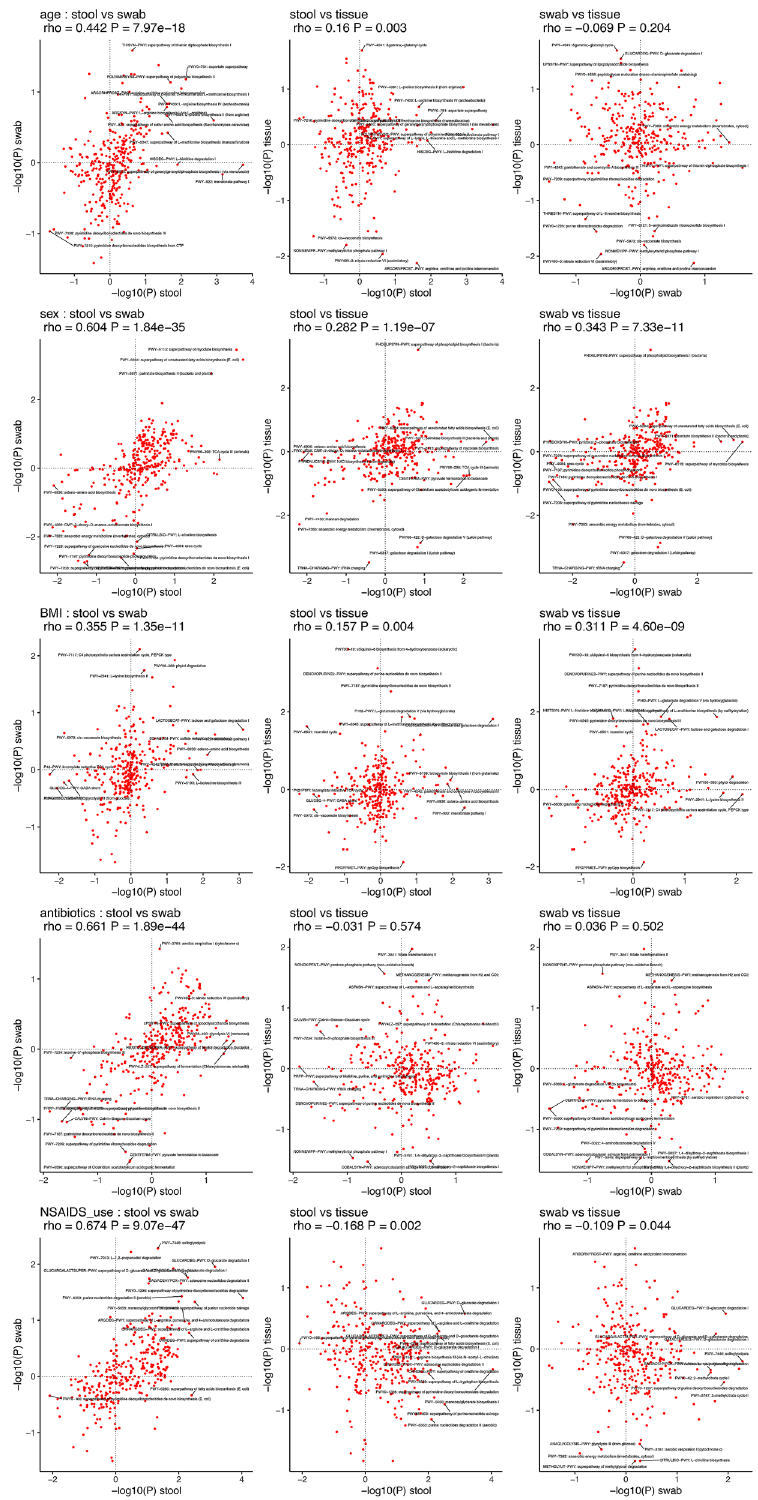
Figure 6. Correlations between the functional pathways inference for age (a) , sex (b) , BMI (c) , antibiotics use (d) , NSAIDs use (e) and between pairwise sample types. The axes showed the p-values that were log10 transformed and multiplied by + 1/−1 to include the direction of changes from the model 2 described in